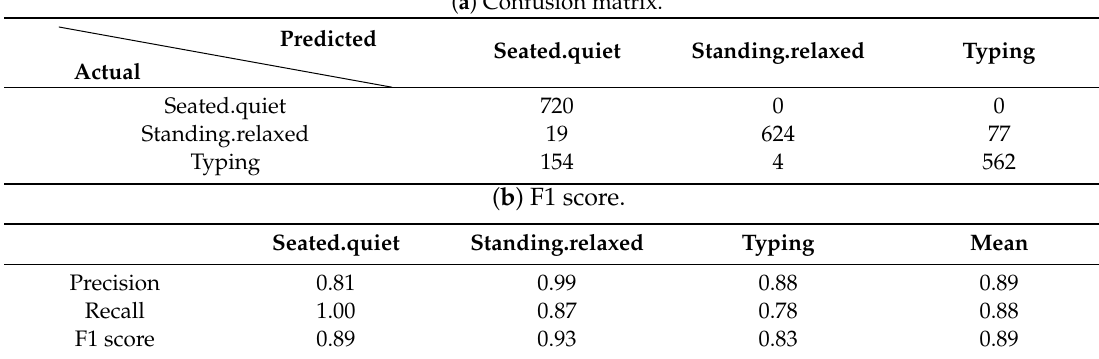
Table 3. Results for the real-time o ffi ce-activity dataset. ( a ) Confusion